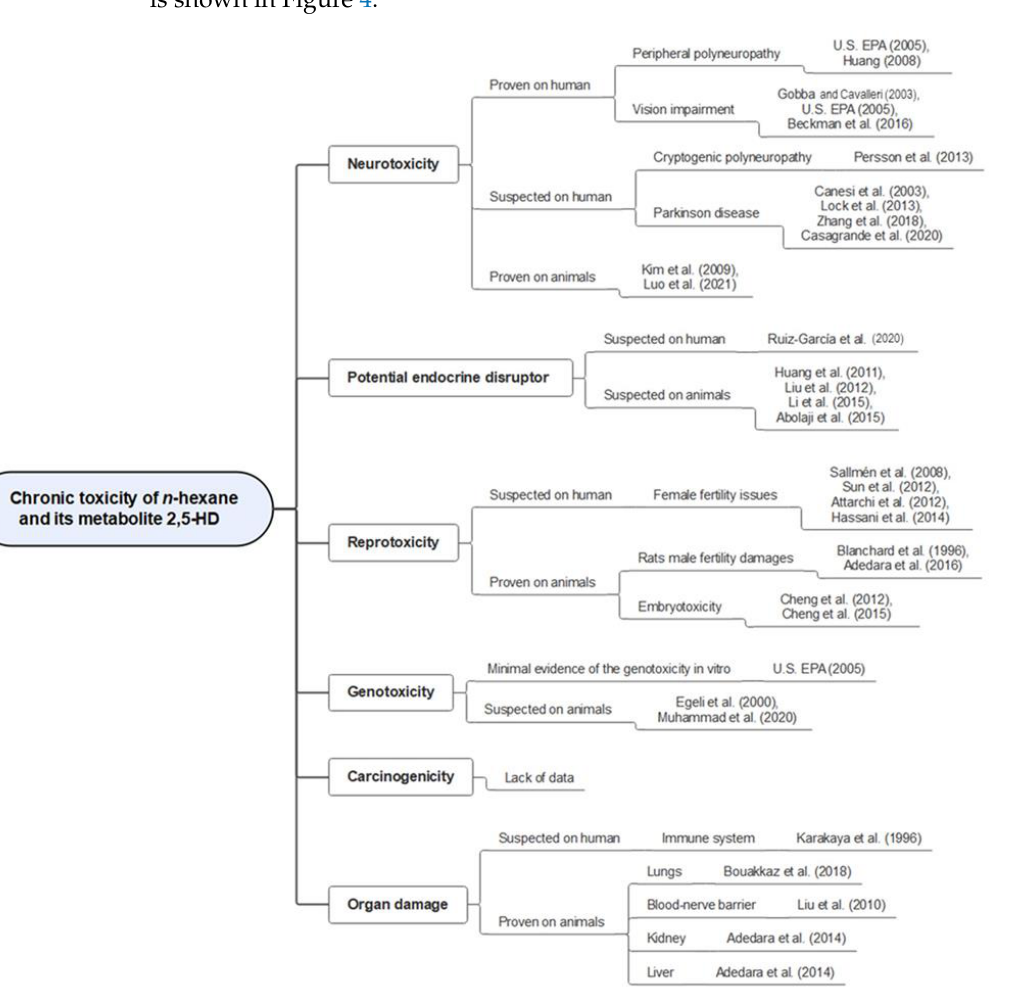
cupational exposure to n -hexane in Taiwan [47,63]. These reviews establish a strong asso- ciation between long-term exposure to n -hexane and the occurrence of peripheral neurop- athies. However, in some studies, workers were exposed to mixtures of volatile solvents, and the proportion of exposure to n -hexane alone was not reported. After cessation of exposure, it was observed that the severity of the neurological deficit increased within 1 to 4 months, with deterioration of muscle strength and sensory deficits being maximal. Symptoms disappeared only slowly, and long-term studies indicated that while motor nerve function recovers more quickly, sensory nerves are more severely affected and may not fully recover until ten years after exposure.